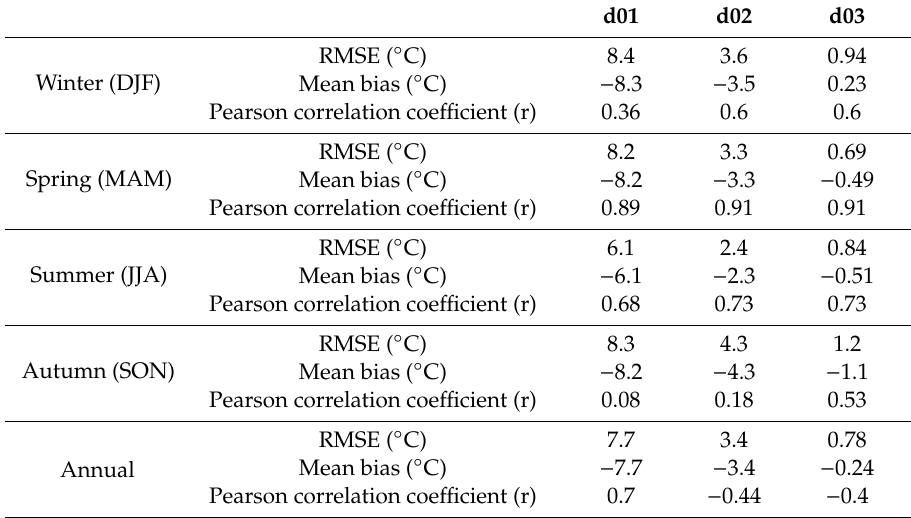
Table 5. Mean RMSE ( ◦ C), mean bias ( ◦ C), and Pearson correlation coe ffi cient (r; unitless) between station-averaged and WRF interpolated lapse rate corrected 2 m air temperature (T2) in d01, d02, and d03.